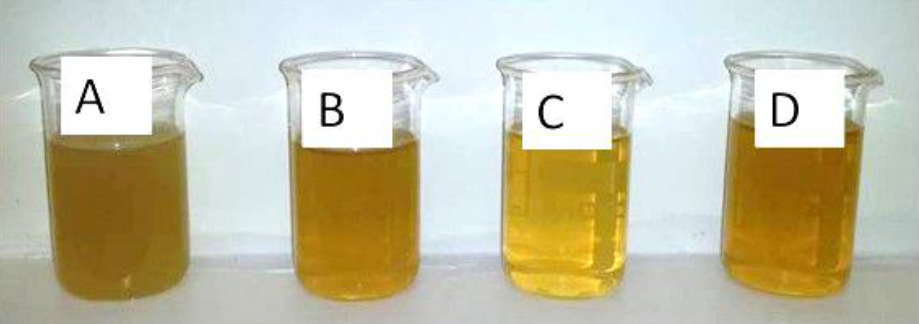
Figure 9. Supernatants of the reactor slurries collected from reactors A – D at the end of the pyrite oxidation experiments. Figure 10 shows dried residues from the pyrite oxidation experiment, and masses of the recovered residues are shown in Table 4. The brown colour on the surface of the residues from reactor A was likely due to cell biomass recovered along with the mineral residues (Figure 10).